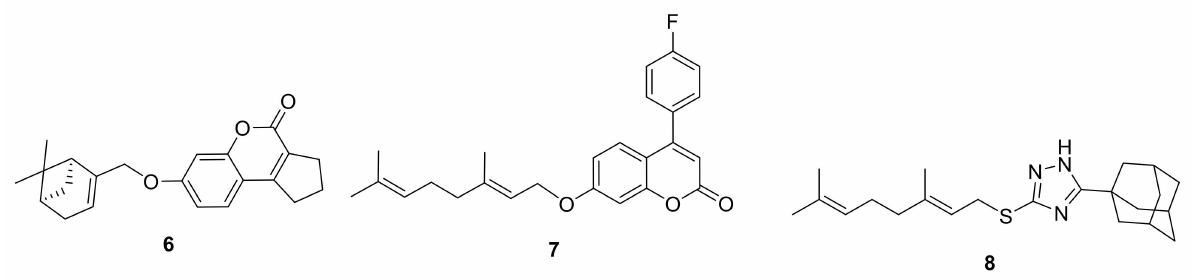
Figure 2. Structures of TDP1 inhibitors with monoterpenoid moieties.